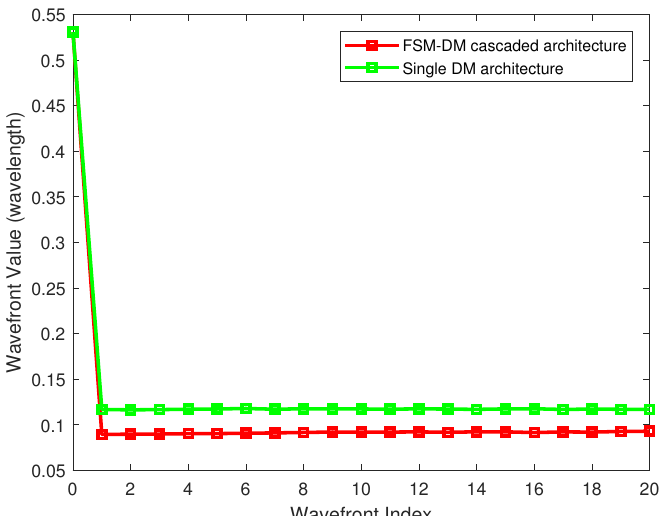
Figure 12. The variation of the wavefont RMS value when compensating a single wavefront input with proposed AO architecture and single DM AO